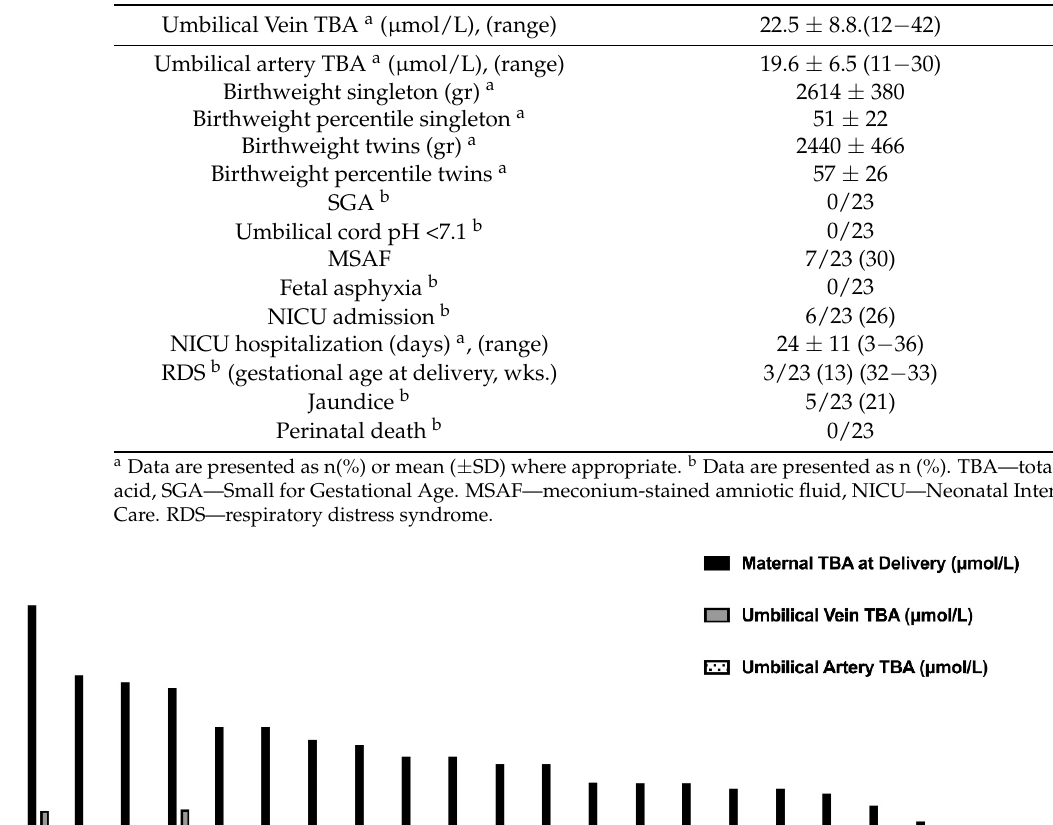
Table 2. The neonatal outcome.